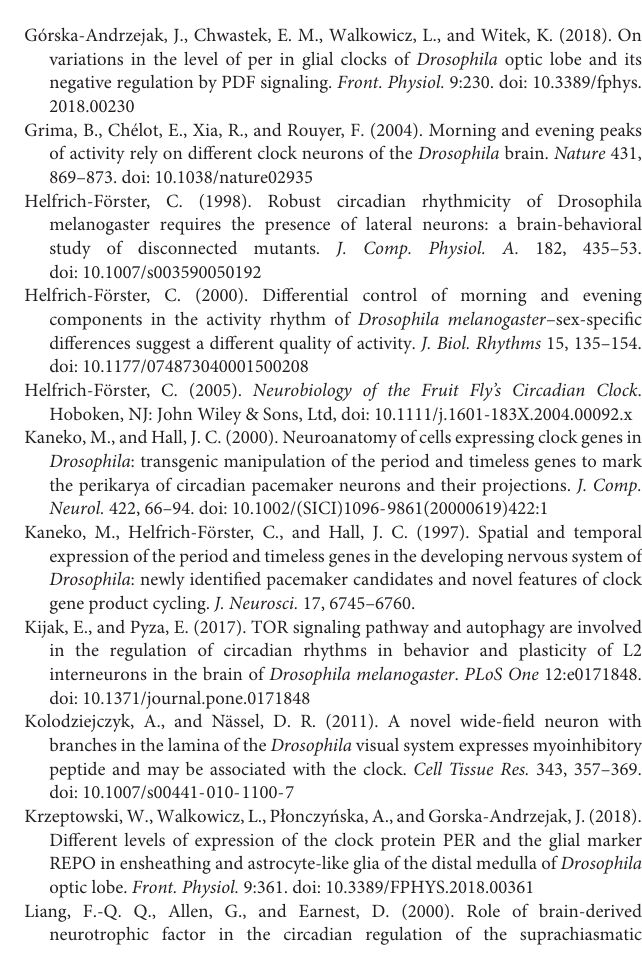
(Mann-Whitney Test, p = 0.153) of total axonal crosses of tim > DmMANF-RNAi flies compared to tim/ + flies. Graphs represent mean ± SD. Supplementary Figure 7 | PER expression in s-LNv and l-LNvs of flies with a decreased level of DmMANF in clock neurons. (A) Double labeling of PER and PDF of whole mount brains dissected at ZT1 and ZT14 time points showed that in both s-LNvs (arrows) and l-LNvs (arrowheads) of tim > DmMANF-RNAi Dcr2 flies and control group PER protein is cycling. (B) Data quantification by measuring pixels intensity for PER channel showed statistical differences of PER fluorescence between timepoints in experimental and control flies bot in l-LNvs and s-LNvs ( t -test with Welch’s correction, p < 0.001). (C) In DD PER level cycle in s-LNvs (arrows) but not in l-LNvs (arrowheads). (D) Fluorescence quantification of PER protein level in different timepoints in DD showed statistically significant changes for s-LNvs in experimental and control groups ( t -test witch Welch’s correction, p < 0.0001) and no changes for l-LNvs ( t -test witch Welch’s correction, p = 0.70 and p = 0.05). N represents the number of individuals for each analysis. Means ± SD, ∗∗∗ - p < 0.01. Me – medulla. Scale bar: 20 µ m. Supplementary Figure 8 | Characterization of flies with silenced expression of DmMNAF under pdf-Gal4 control. (Upper panel) PDF immunostaining of the projections of the s-LNvs in the dorsal brain and of the l-LNvs in the medulla. Flies with reduced DmMANF expression (pdf > DmMANF-RNAi and pdf > DmMANF-RNAi Dcr2 ) are compared to the control ( pdf / + ). Supplementary Figure 9 | Cross sections of the L2 axon with dendrites in wild-type flies and MARCM